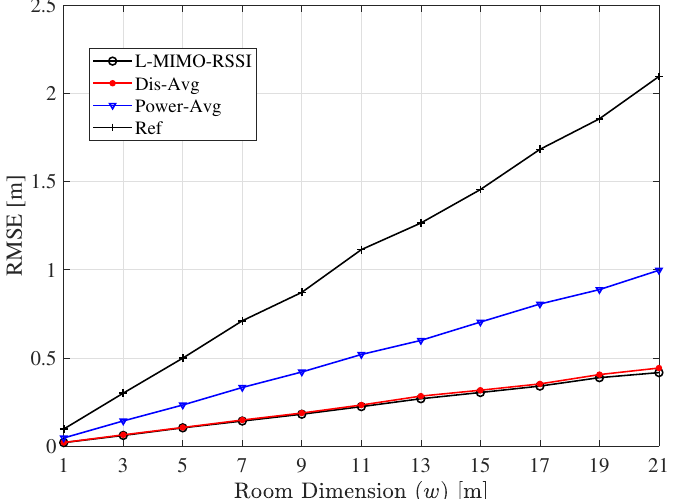
Figure 18. The RMSE for the proposed algorithms for different indoor area dimensions w 1 = w 2 = w . M = 50, N = 8, σ = 3, α =